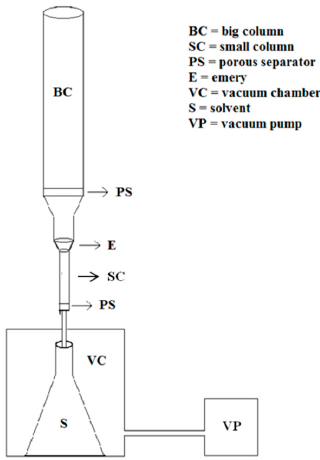
Figure 1. System for rapid extraction of fat from powered pasta and lyophilized egg.